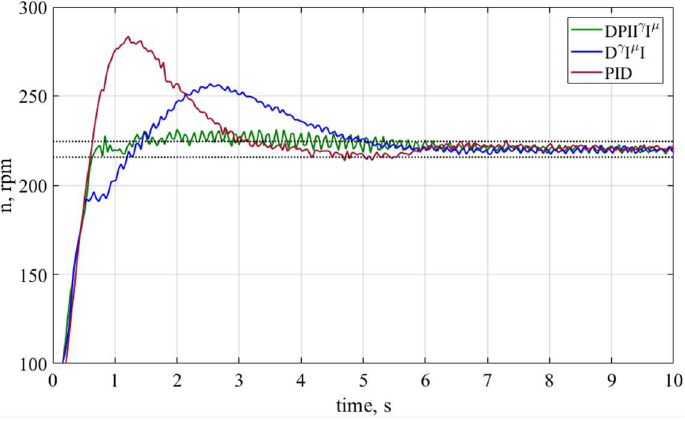
Figure 11. Graphs of transient processes with a rapid increase in fuel supply to the internal combus- tion engine.